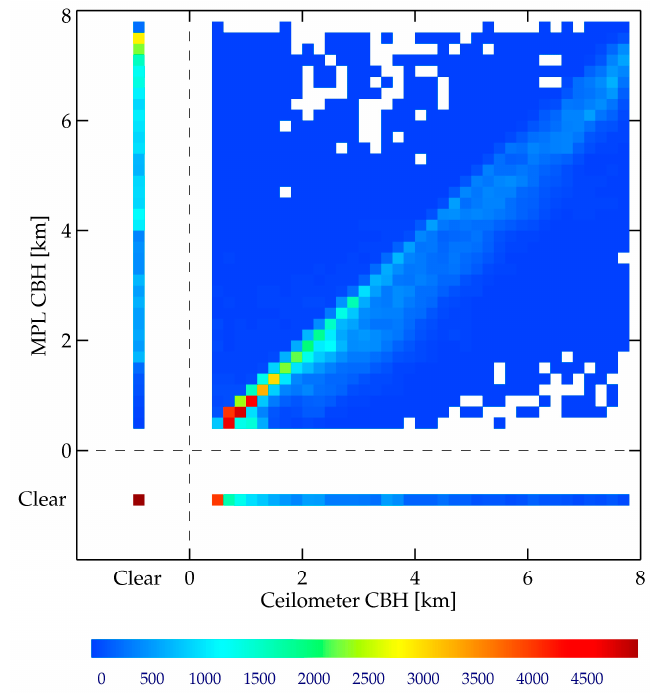
Figure A1. The number distribution of CBHs between ceilometer and MPL at the ARM SGP site over one year (1 November 2014–31 October 2015). The number count within each bin is expressed with the different colors. The size of each bin is 0.2 km, and the total data are 404,971 points. Here, “Clear” indicates that no significant backscattering signal is detected at each instrument.